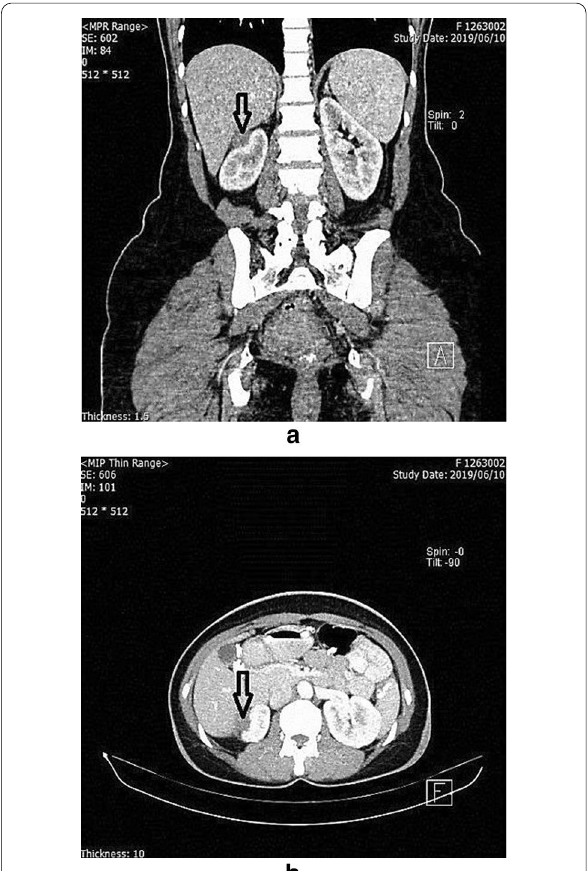
Fig. 1 a Abdominopelvic CT showing a heterogeneous mass (black arrow) with pressure effect on the upper pole of the right kidney (coronal view). b . Abdominopelvic CT showing a heterogeneous mass (black arrow) with pressure effect on the upper pole of the right kidney (axial view)